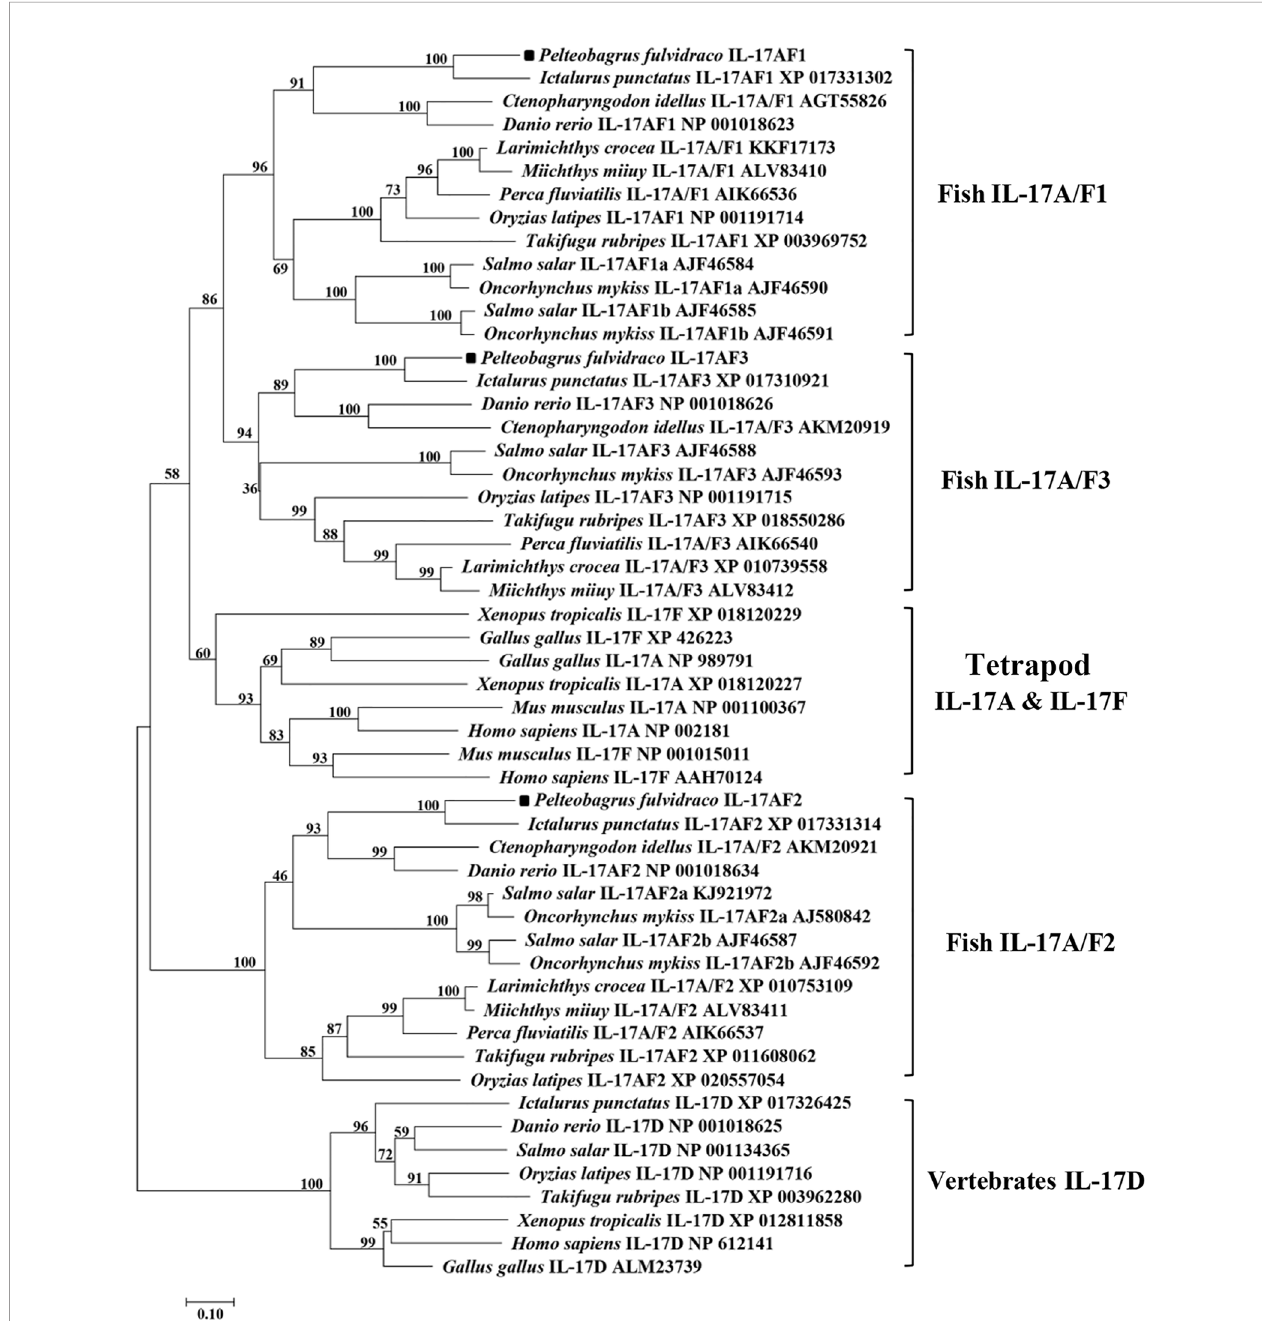
FIGURE 2 | Neighbor-joining (NJ) phylogenetic tree constructed based on deduced amino acid sequences of vertebrate IL-17A/F using MEGA 6.06. A bootstrap analysis is performed using 1000 replicates to test the relative support for particular clades. GenBank accession number for each sequence is given after the species name and molecular